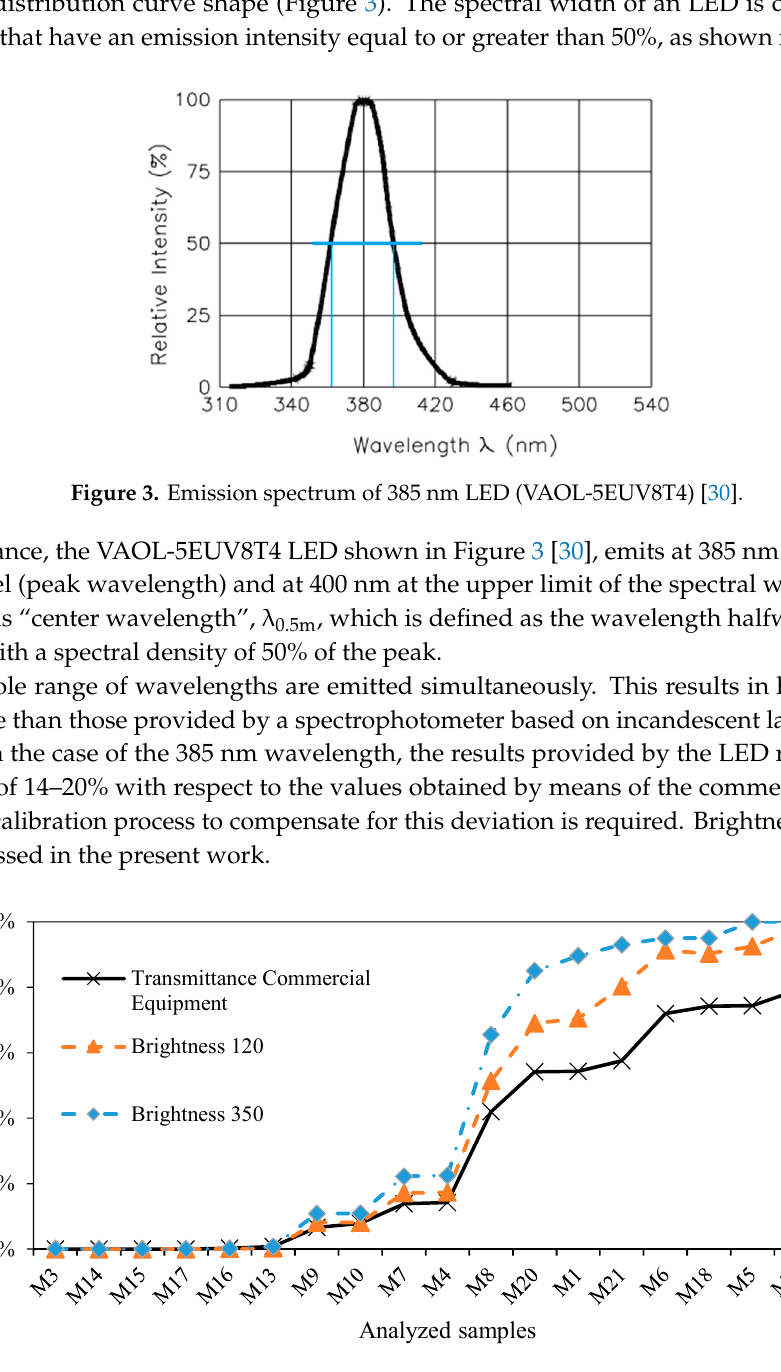
Figure 4. Transmittance comparison at 385 nm between commercial equipment and LED VAOL- 5EUV8T4 [30] with two different brightnesses.